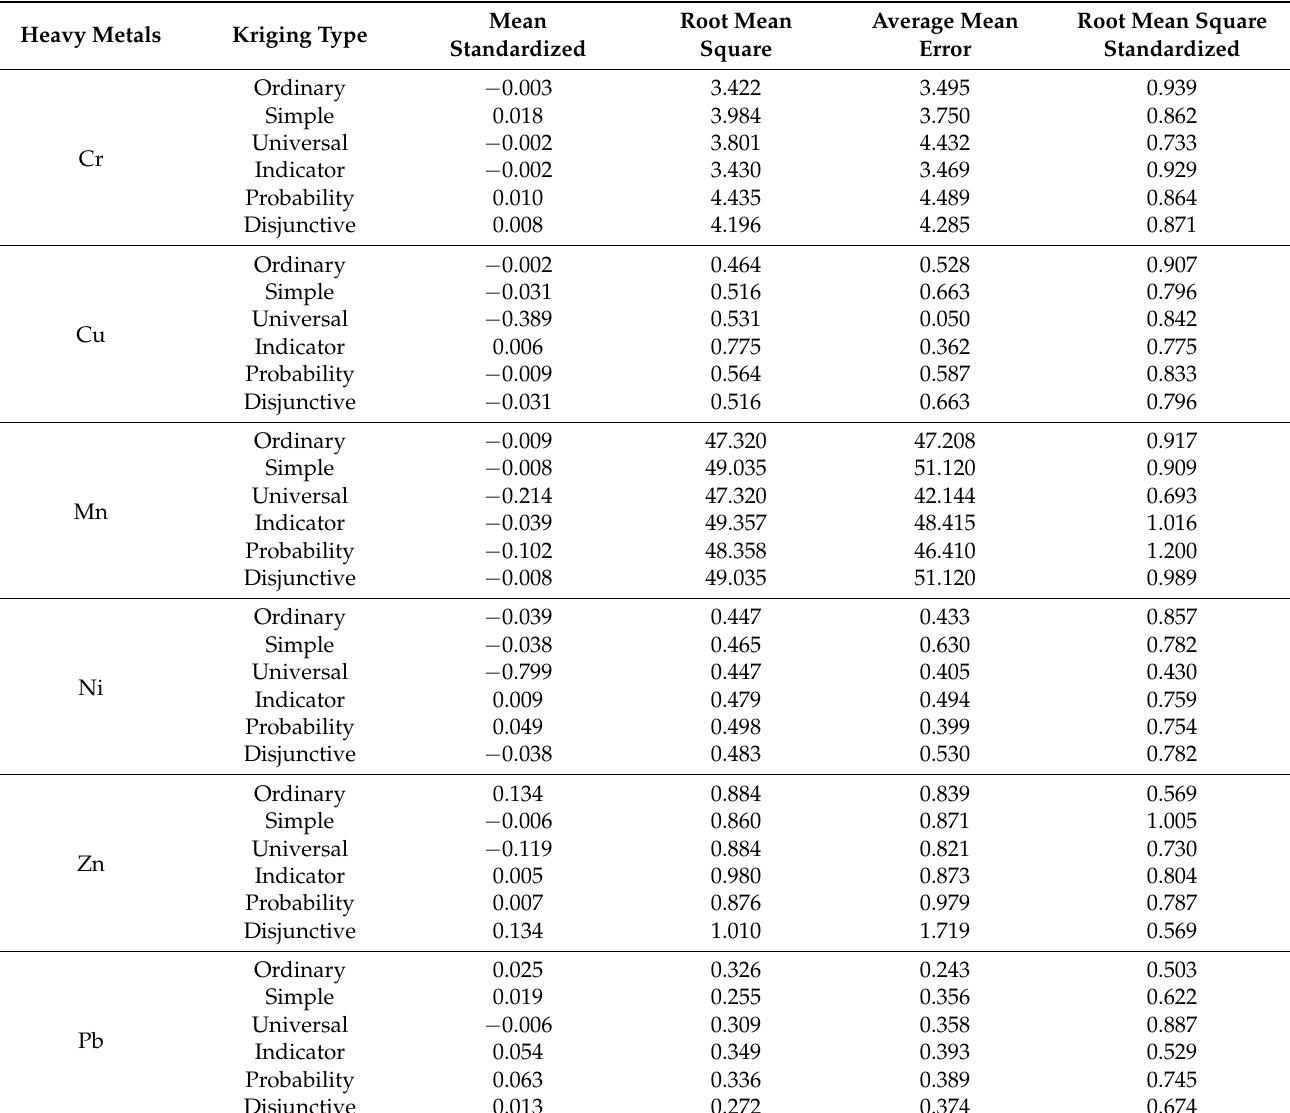
Table 3. Error comparison of spatial interpolation methods for heavy metal content in surface soil of mining